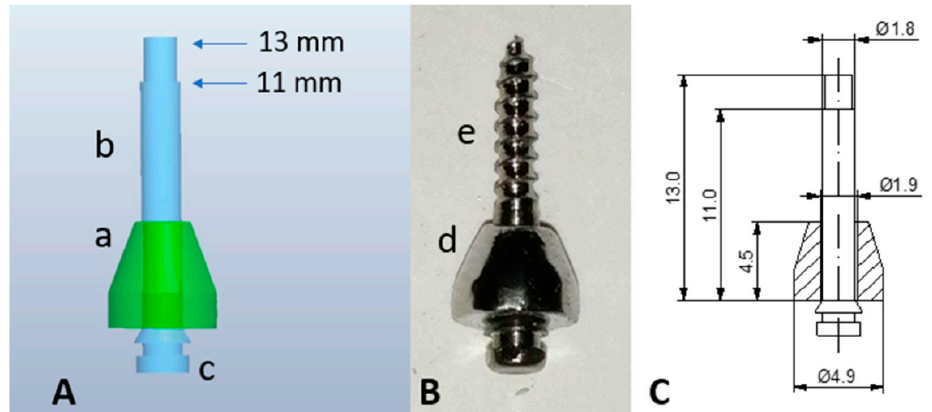
Figure 4. Bushing and miniscrew utilized in the DIVA appliance. ( A ) Virtual model of the bushing (a) and miniscrew (b). The head of miniscrew is represented by (c). ( B ) Physical bushing produced with additive manufacturing (d) and conventional prefabricated miniscrew (e). ( C ) Drawing with dimensions expressed in mm.